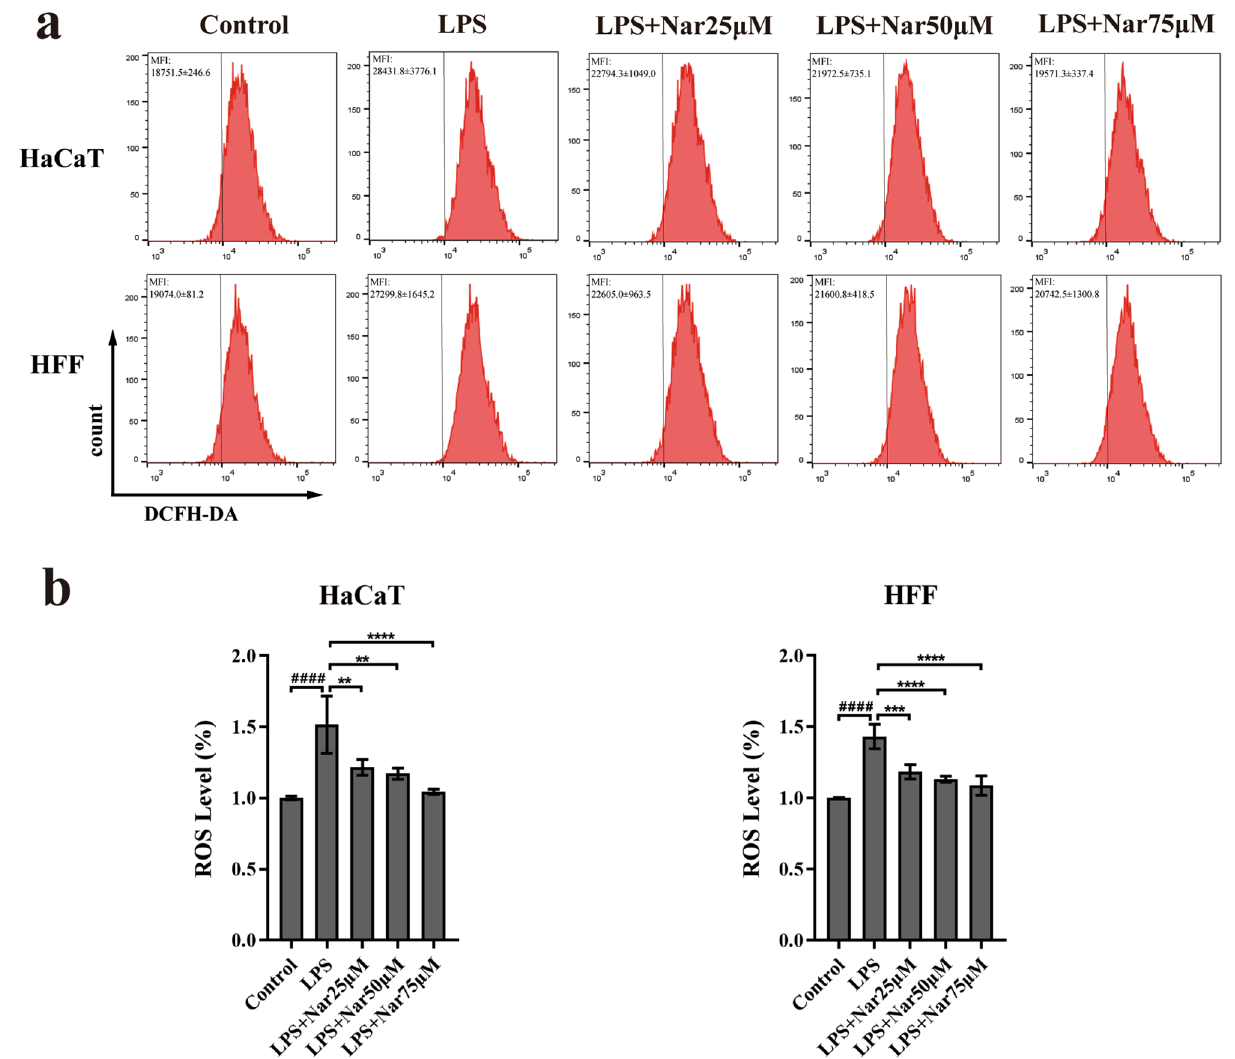
Figure 8. Effect of naringenin on intracellular ROS production. ( a ) HaCaT cells and HFFs were pretreated with (or without) naringenin (25 µM, 50 µM, or 75 µM) for 3 h and then exposed to LPS (0.5 µg/ml) for 12 h. Fluorescence was detected using flow cytometry. ( b ) Changes in ROS levels. For all studies n ≥ 3. Error bars show the means ± SDs. Bar chart data were compared by ANOVA. #### P < 0.0001 compared with the control group, and * P < 0.05, ** P < 0.01, *** P < 0.001, and **** P < 0.0001 compared with the LPS